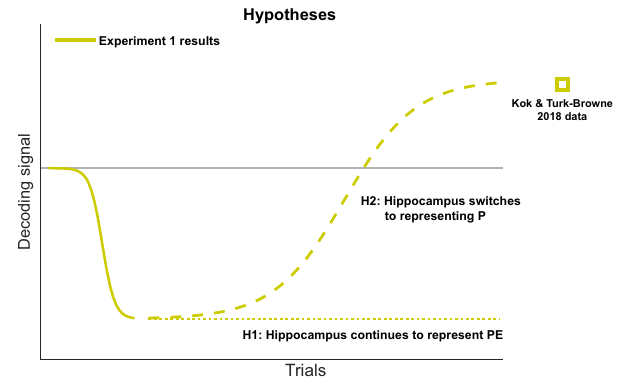
Fig. 4 Hypotheses for Experiment 2. Experiment 1 revealed a negative shape decoding signal (solid line). Lengthening the learning phase may either result in this effect continuing (H1, dotted line), or lead to a switch towards positive prediction signals once learning is complete (H2, dashed line). Square indicates results from ref. 27 , where participants were acquainted with the predictive cues before the fMRI